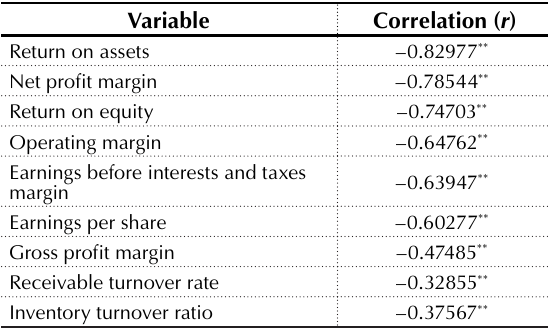
Table 5. The correlation between the I 2 -distance